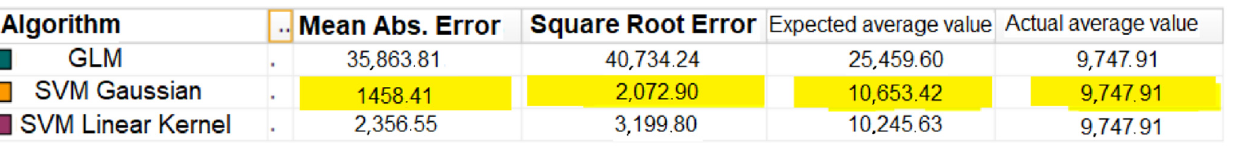
Figure 10. Validation of the model using different algorithms. In the comparison of the three models, it is observed that the lowest errors, both for MAE and RMSE , are those obtained with the SVM model with Gaussian Kernel. Therefore, based on these data, the selection of this algorithm to generate the final model is justified. The real data for the year 2020 are used for the error